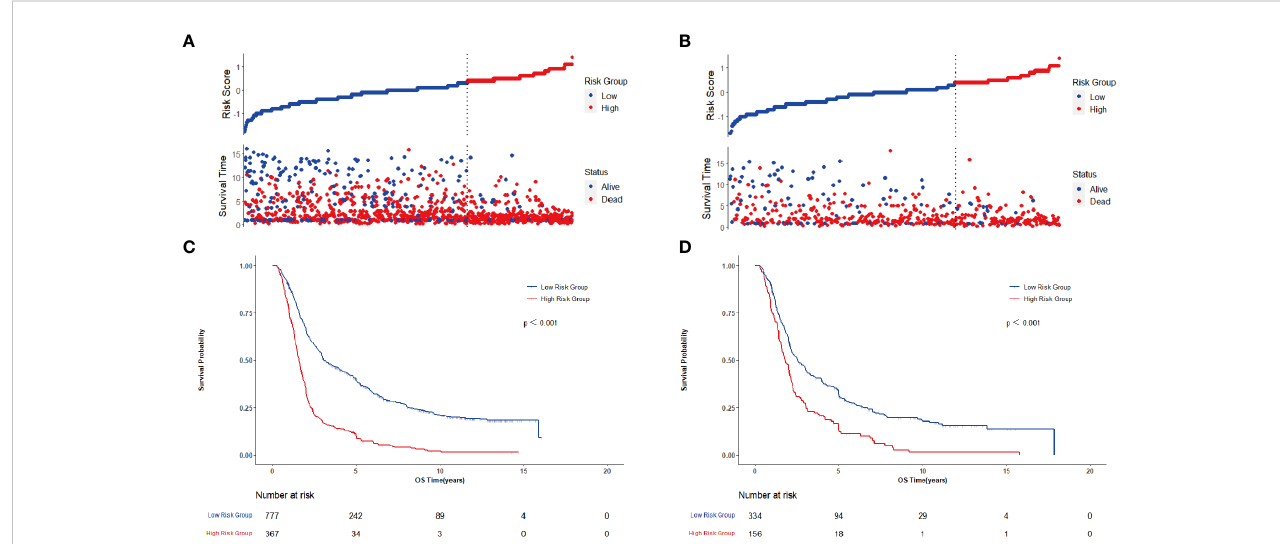
FIGURE 7 Evaluates of clinical-pathological nomogram model performance in training cohort and con fi rms on the basis of validation cohort. (A) Distribution of risk scores and survival status in training cohort; (B) Distribution of risk scores and survival status in validation cohort; (C) Kaplan-Meier survival curve in training cohort; (D) Kaplan-Meier survival curve in validation